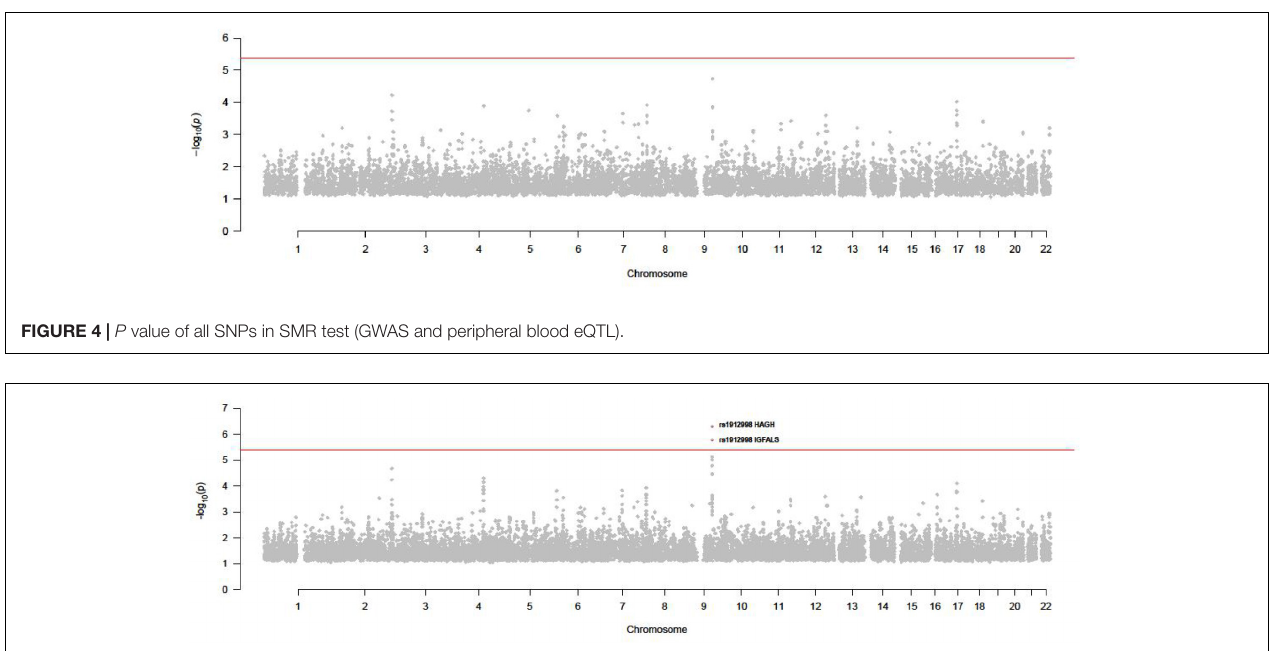
FIGURE 3 | Workflow of our work.